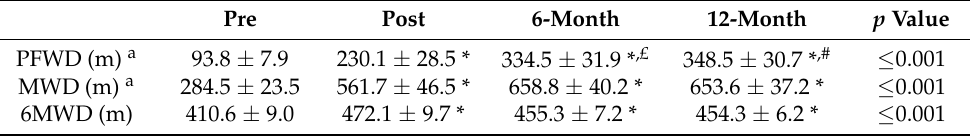
Table 2. Evolution of PFWD, MWD, and 6MWD after supervised exercise training (SET).